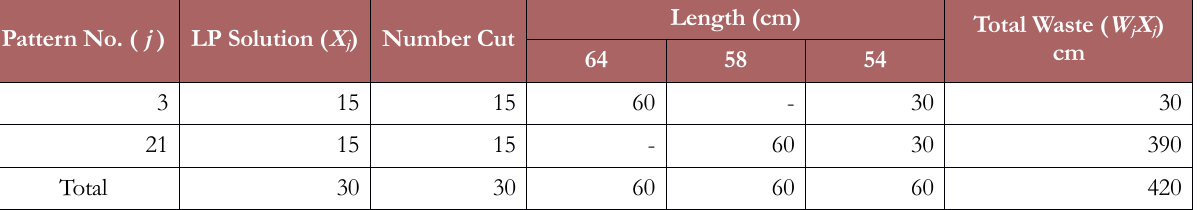
Table 7. Number of 9cm width to be used to produce Product I (Case